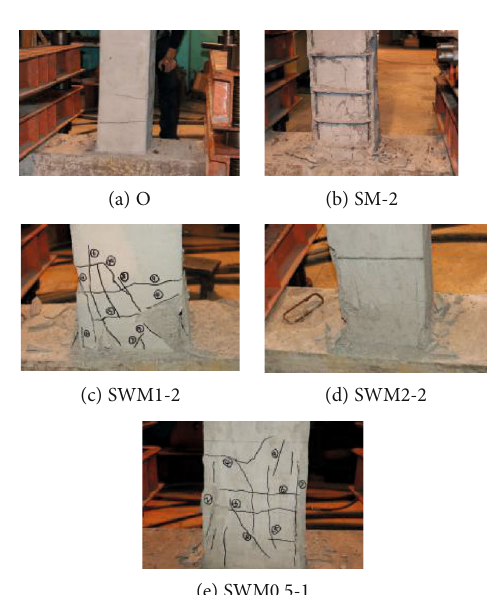
Figure 4: Loading regime.